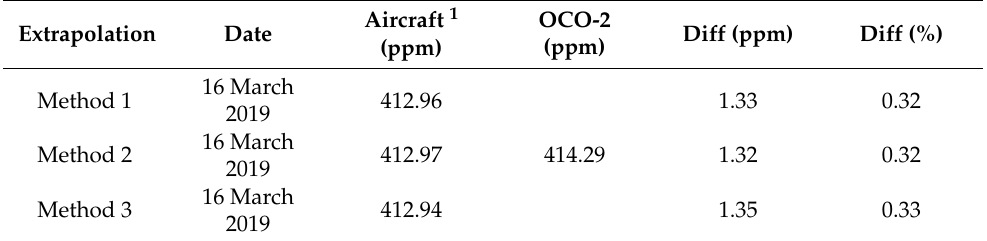
Table 4. The XCO 2 derived from the aircraft measurements using extrapolation Method 1 (satellite a priori concentrations), Method 2 (using GEOS-Chem profiles), and Method 3 (using CarbonTracker profiles), OCO-2 XCO 2 values, the difference (OCO-2—Aircraft) in terms of ppm, and the relative difference